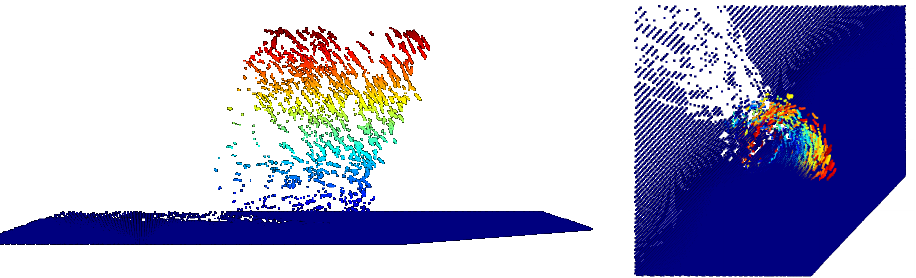
Figure 18. Dynamic scan of a virtual fish swarm ( left : side perspective, right : top perspective).